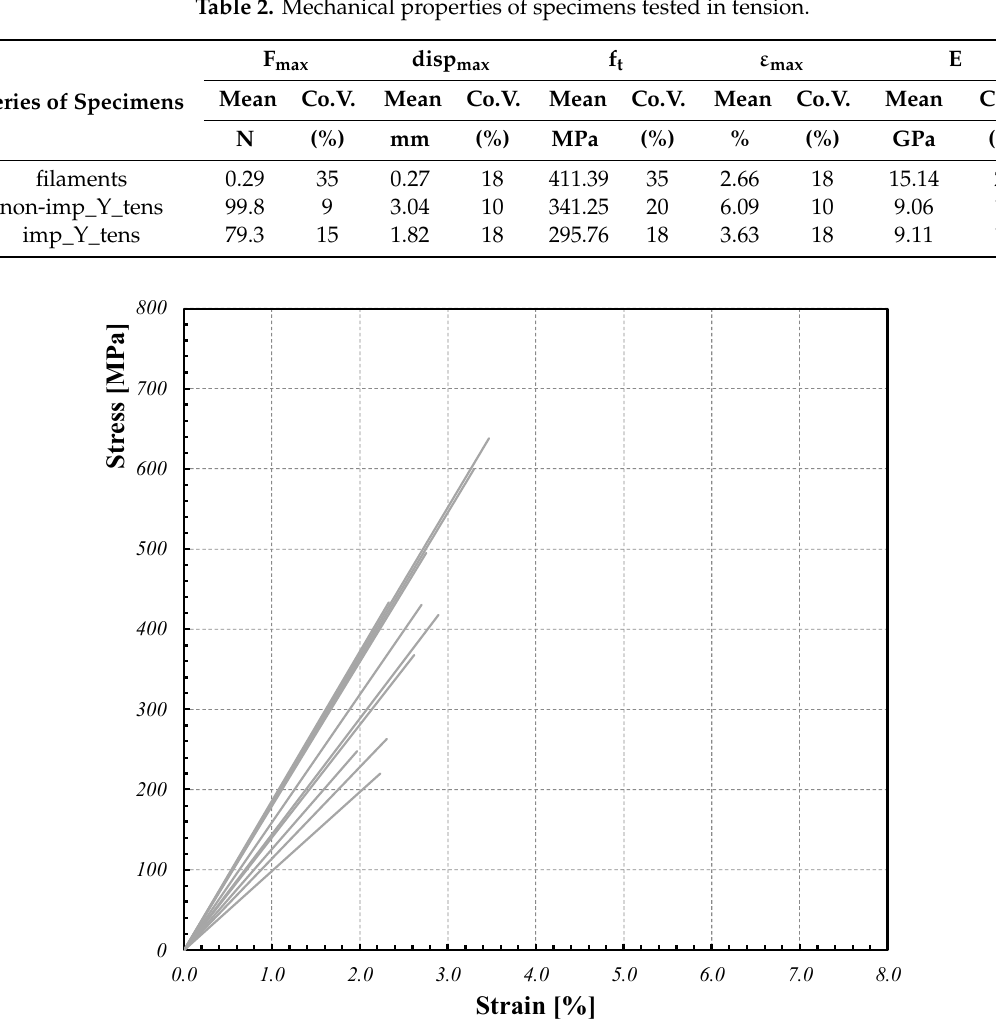
Figure 9. Tensile test results on filament series.